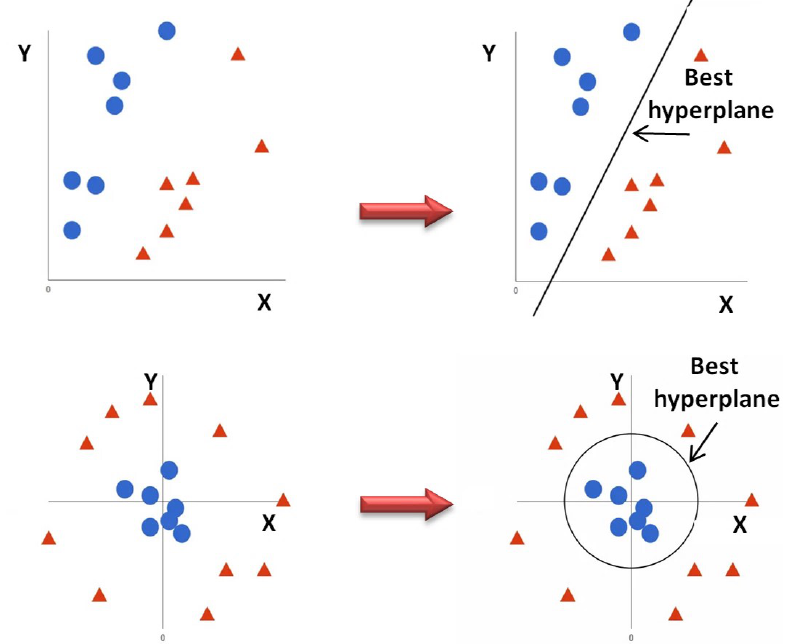
Figure 4. The basics of support vector machines (SVM) and the workflow of classification. The classification is done based on the wildfire inventory data that is introduced to the model as a layer consisting of the value of one for wildfire pixels and zero for the other